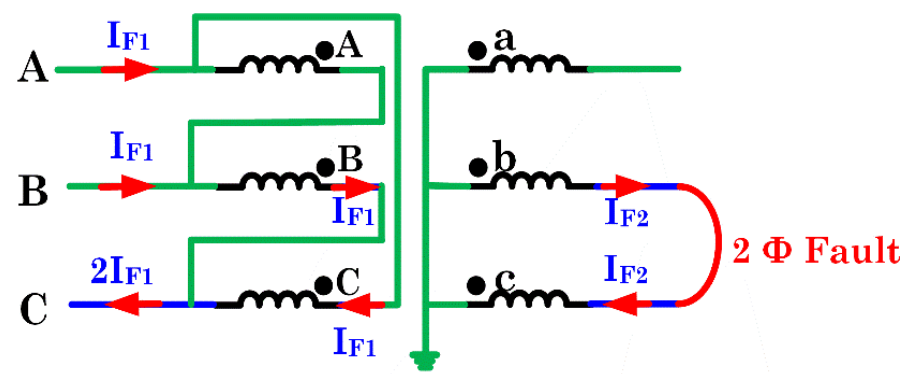
Figure 6. The 2-phase fault currents distribution over Dy11 distribution transformer.